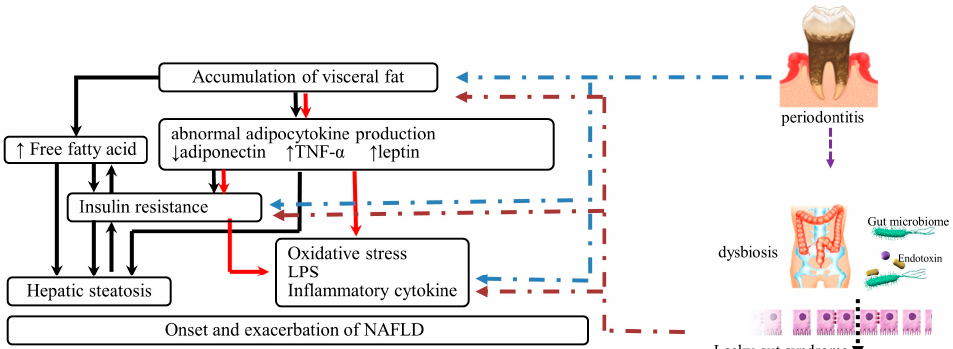
Figure 1. Pathogenic Mechanisms Linking Periodontal Disease and NAFLD. NAFLD, nonalcoholic fatty liver disease; TNF, tumour necrosis factor; LPS, lipopolysaccharide; ↑ , increase in blood concentration ; ↓ , decrease in blood concentration